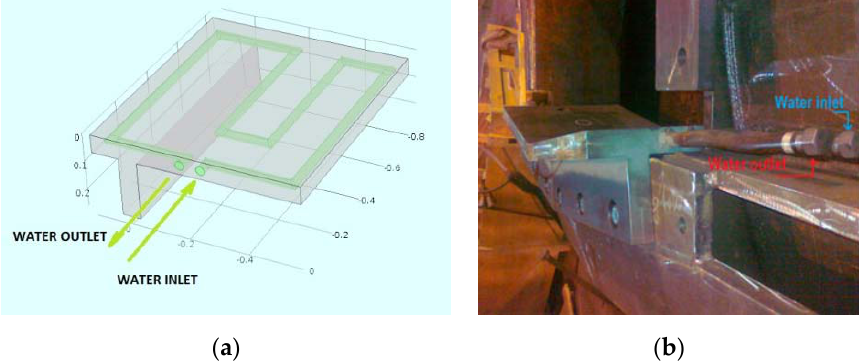
Figure 4. ( a ) Original plate design; ( b ) detail of the cooling water connections in the bottom plates.